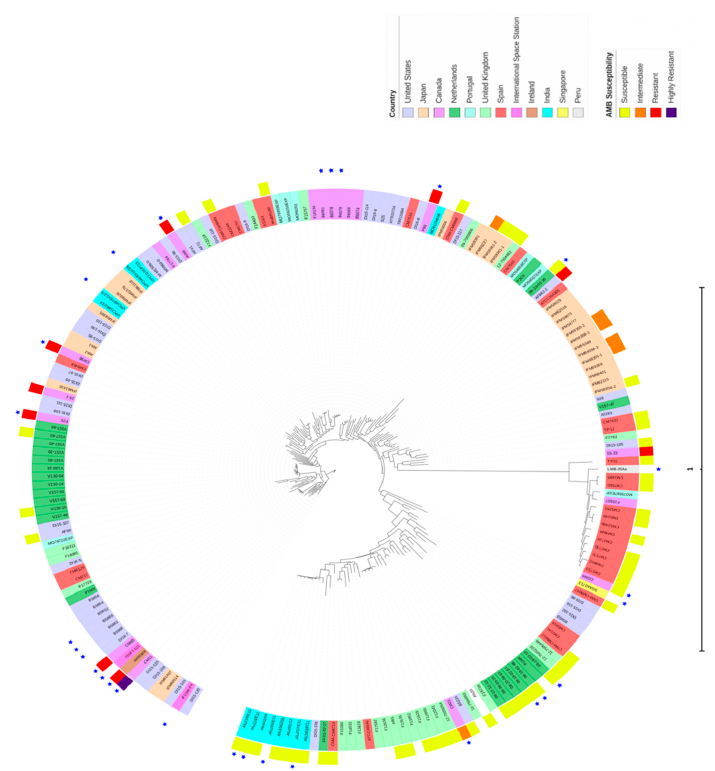
Figure 2. Phylogenetic tree of the 196 A. fumigatus strains in the study. Circular phylogram of maximum-likelihood phylogeny rooted to the reference Af293 was constructed using the Randomized Axelerated Maximum Likelihood (RAxML) and Interactive Tree Of Life (iToL) programs. Scale bar represents substitutions per nucleotide site.